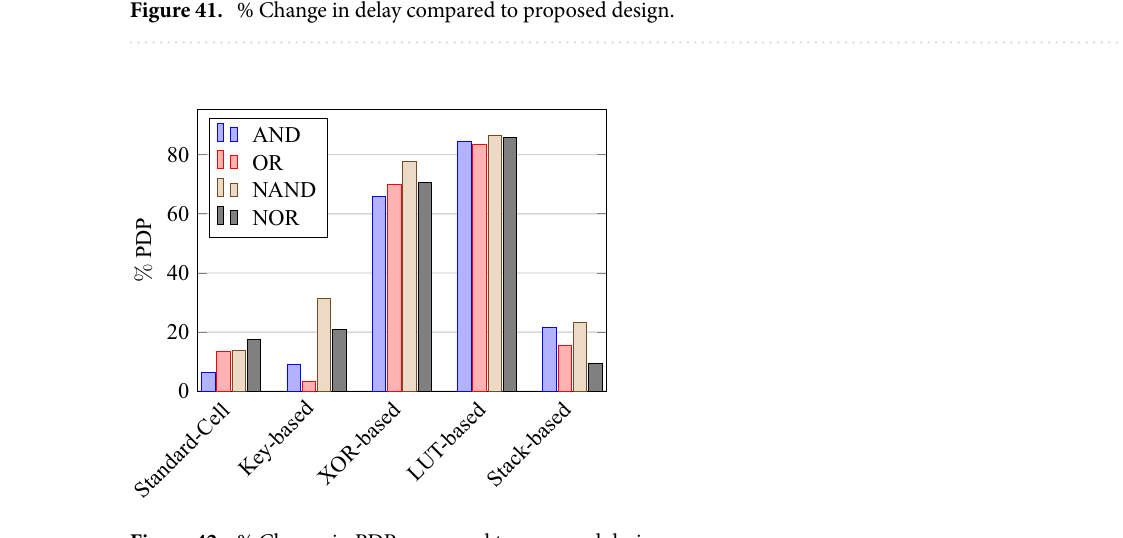
Figure 42. % Change in PDP compared to proposed